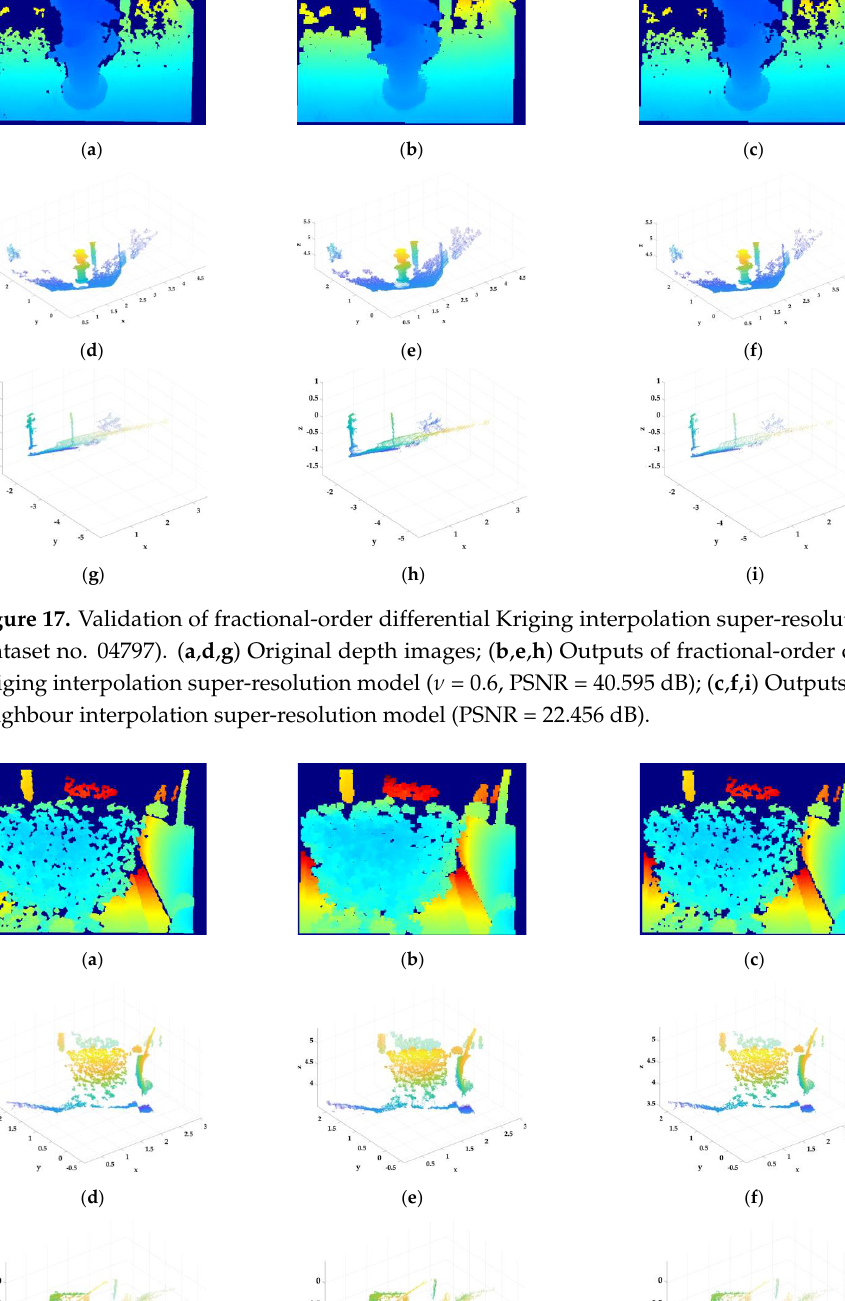
Figure 16. Validation of fractional−order differential Kriging interpolation super−resolution model (dataset no. 03528). ( a, d, g ) Original depth images; ( b, e, h ) Outputs of fractional−order differential